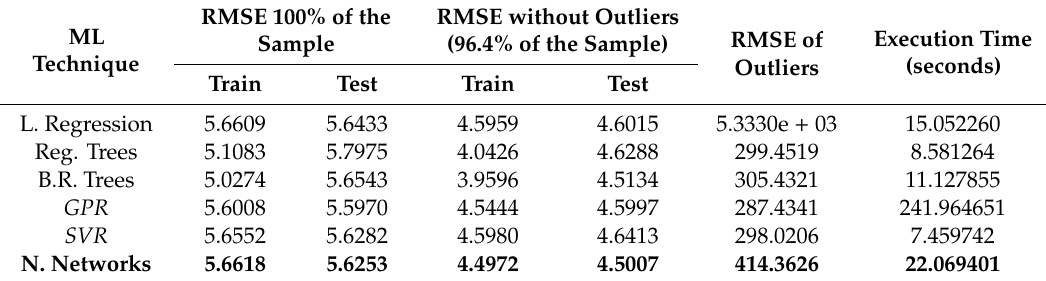
Table 5. BMI-CTDI VOL results for women’s Skull